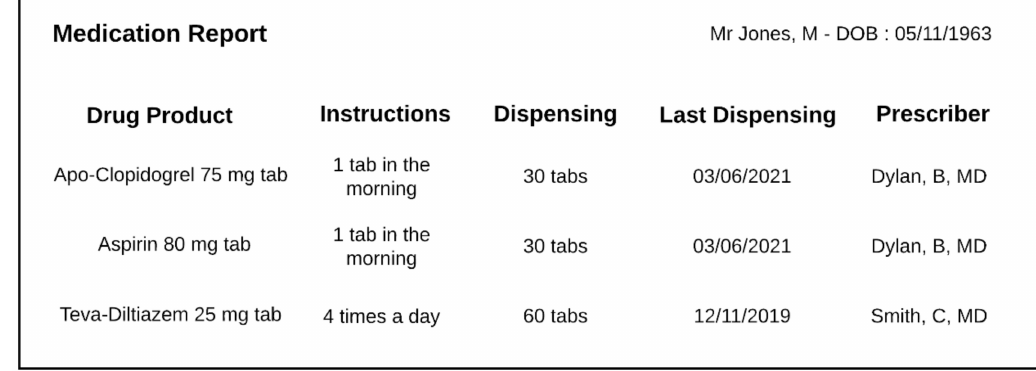
Figure 3. Example of a typical pharmacist dispensing report. Each line contains elements from a dispensing record